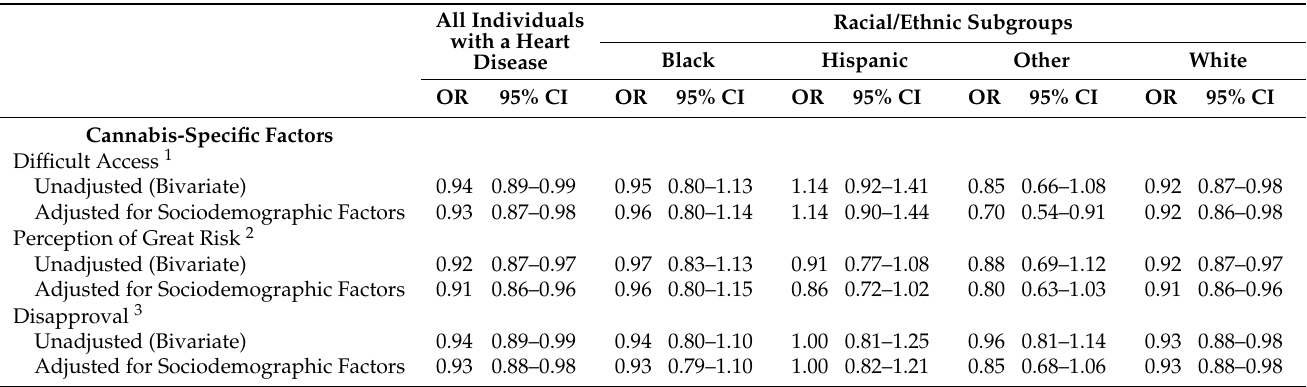
Table 3. Test of trends in cannabis-specific contexts among adults with heart disease: pooled sample of NSDUH 2015–2019. Racial/Ethnic Subgroups Black Hispanic